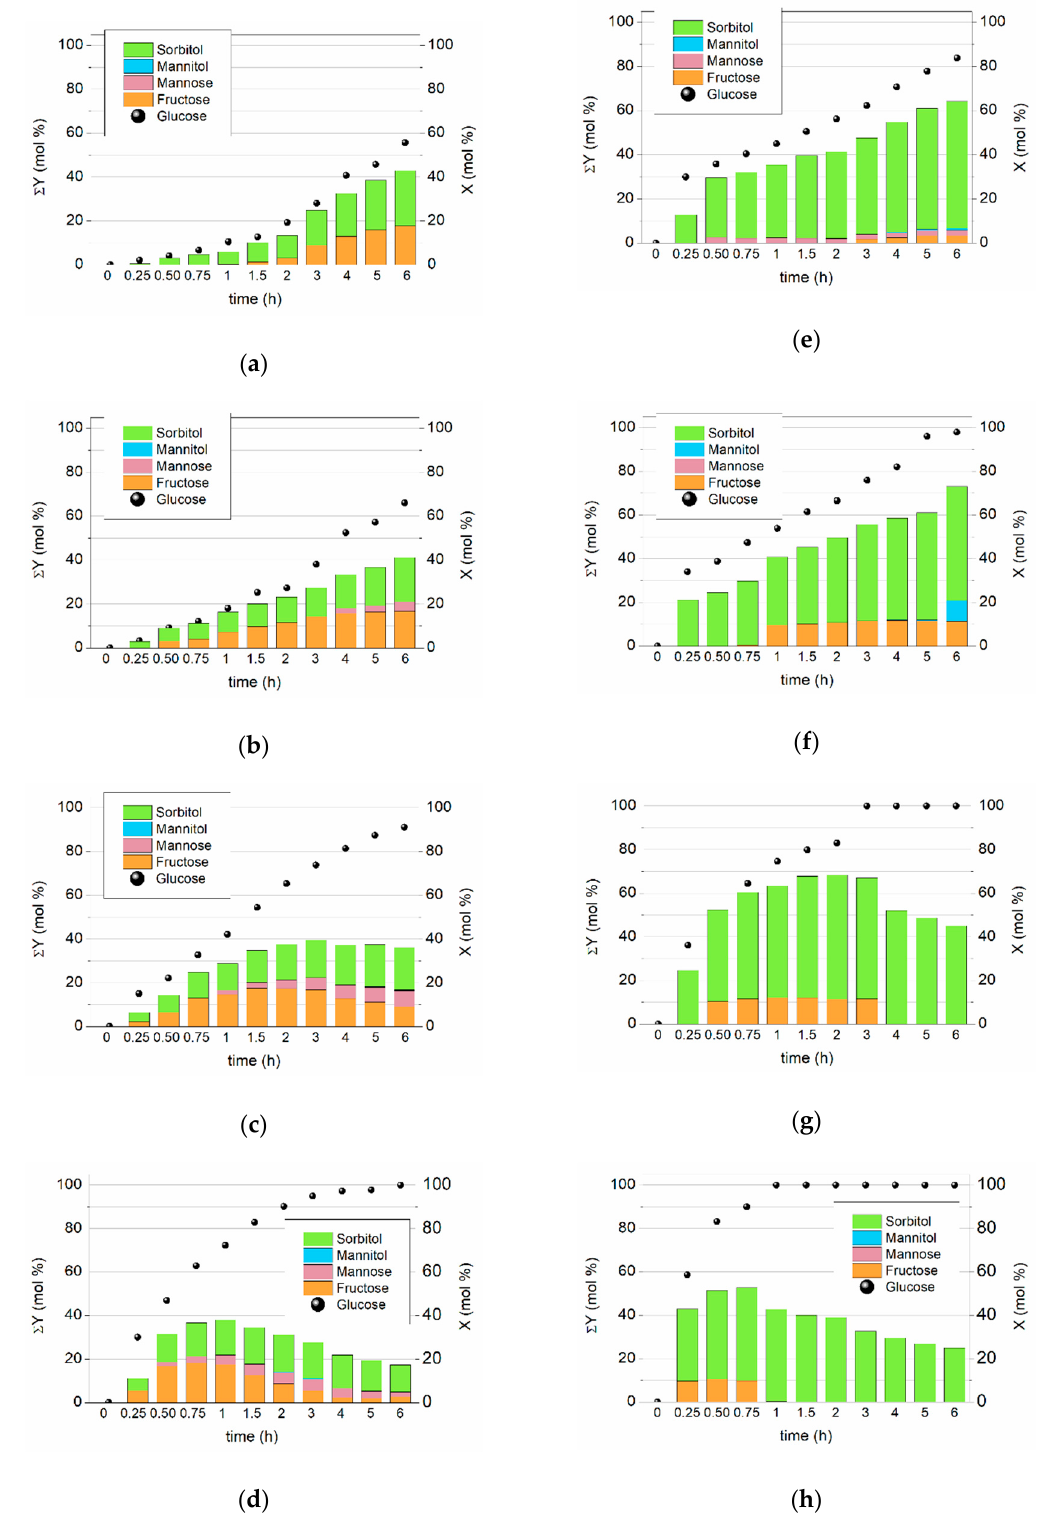
Figure 3. Cumulative product yields (bars, left axes) and substrate conversion (dots, right axes) achieved in the catalytic transfer hydrogenation of glucose in ethanol in the presence of Raney nickel catalyst with different substrate-to-catalyst weight ratios (1:8— left column, graphs a – d ); (1:1— right column, graphs e – h ). Reaction conditions: substrate concentration = 90 mM; reaction time = 6 h; reaction temperature = 130 °C ( a , e ), 150 °C ( b, f), 170 °C ( c , g ), and 190 °C ( d , h ).